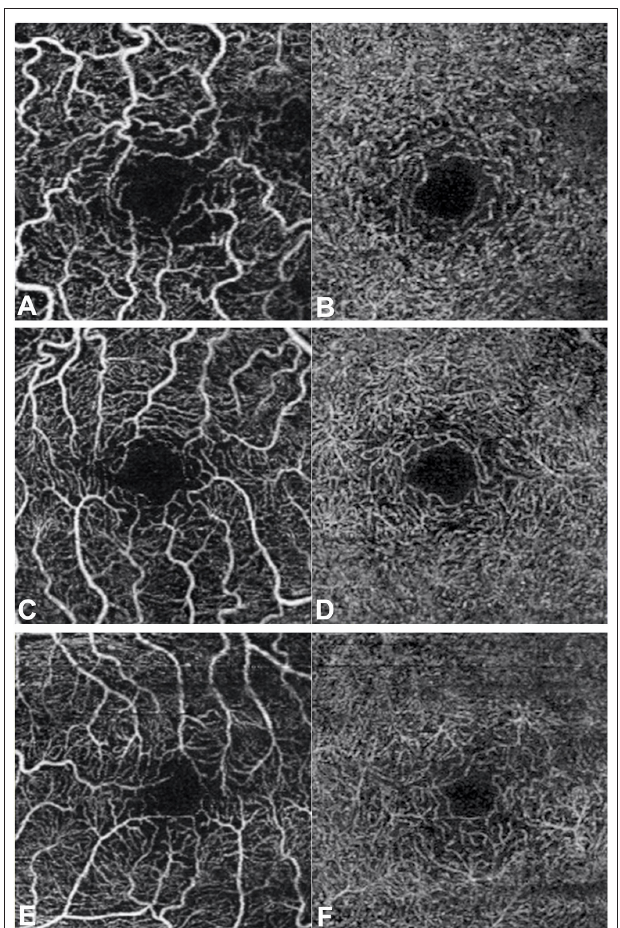
FIGURE 3 | Optical coherence tomography angiography scans (3 × 3mm) in patients with Fabry disease. Rarefaction of the vascular texture of both the superficial capillary plexus (A,C,E) and the deep capillary plexus (B,D,F) can be